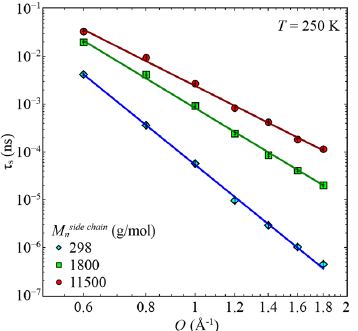
Fig. 9. Segmental relaxation time, τ (cid:2929) , as a function of momentum transfer, Q , for all three samples at T (cid:3404) 250 K. Solid lines are the descriptions with the power law with exponents, (cid:3398) s (cid:3404) 7.2 (blue diamonds, Sample 1), (cid:3398) s (cid:3404) 5.0 (green squares, Sample 2), and (cid:3398) s (cid:3404) 4.2 (red circles, Sample 3). Data has been previously published at Bichler et al .[14]